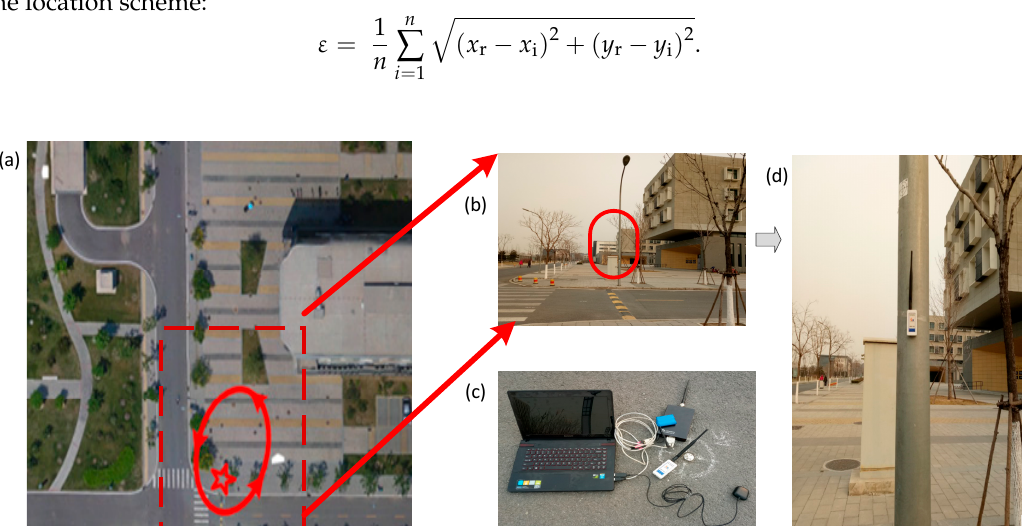
Figure 4. Experimental devices and area. ( a ) Overview of experimental area; ( b ) overview of target object; ( c ) experimental devices; ( d ) detail of target object.